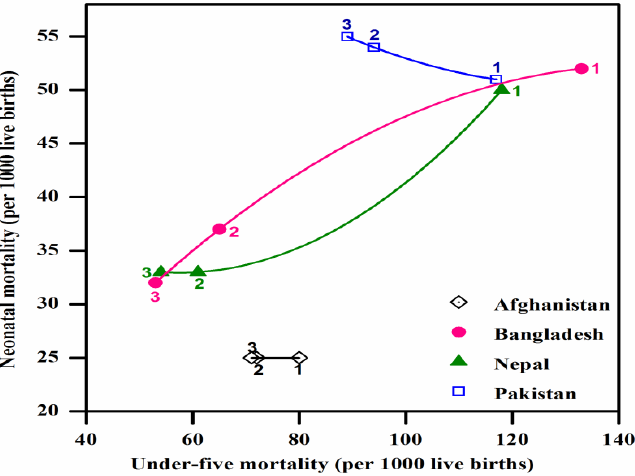
5M: Under-five mortality; NM: Neonatal mortality; ↓ : decreasing trend; ↑ : increasing trend; Under-five and Neonatal mortality indicators given as per 1000 live births; Data point: Data point 1 refers to data from the oldest Demographic and Health Survey (DHS), and data point 3 refers to data from the latest DHS; Expected year of achieving MDG4 from mdgtrack.org.